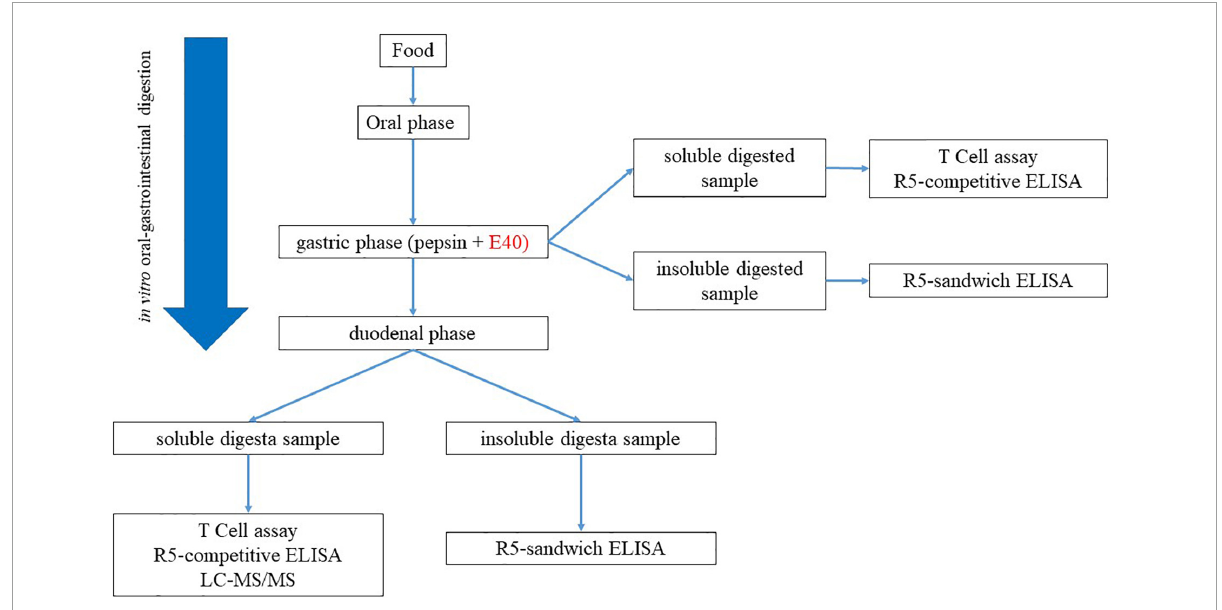
FIGURE1 Experimental workflow for the assessment of GIPs in gastric and gastrointestinal;